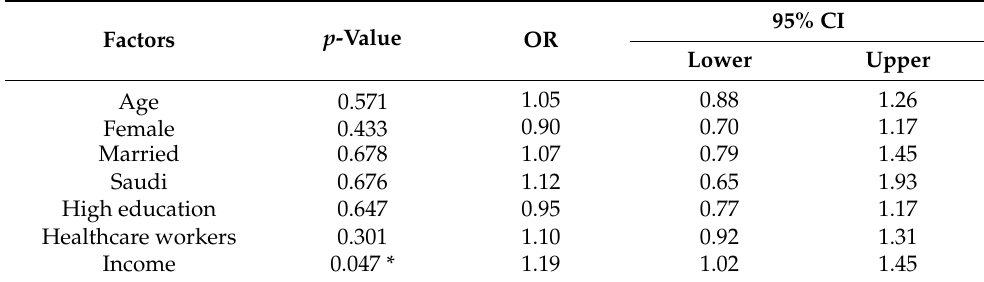
Table 5. Multiple logistic regression model for determinants of participants’ attitude towards the safety of foods sold by the food